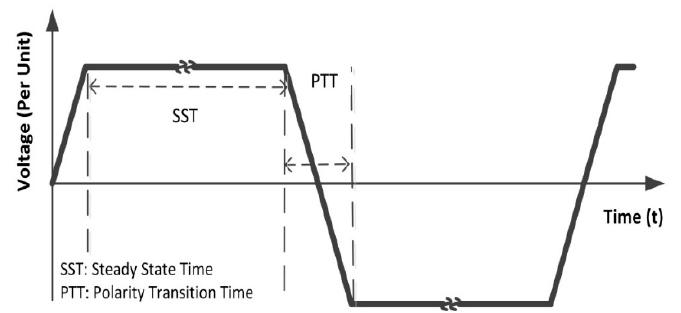
Figure 5. A typical applied polarity reversing voltage.